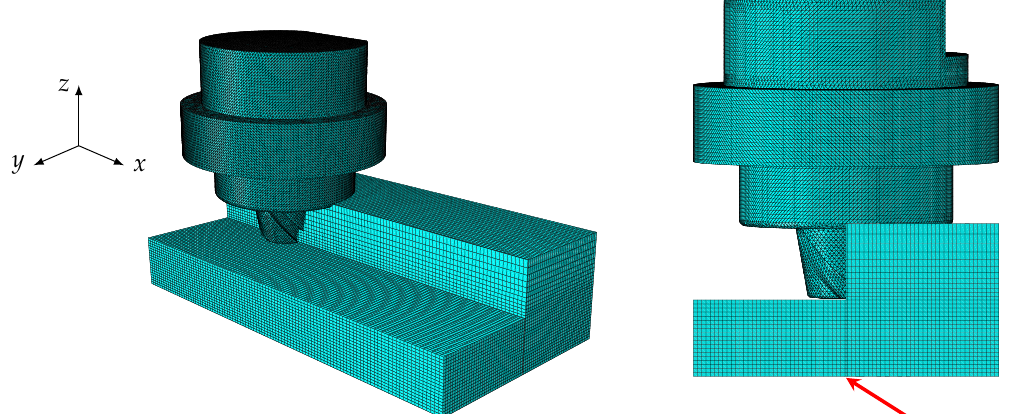
Figure 5. Setup of numerical model with meshing of Lagrangian tool and Eulerian region, isometric and rear view, Eulerian region partially hidden in each case on the